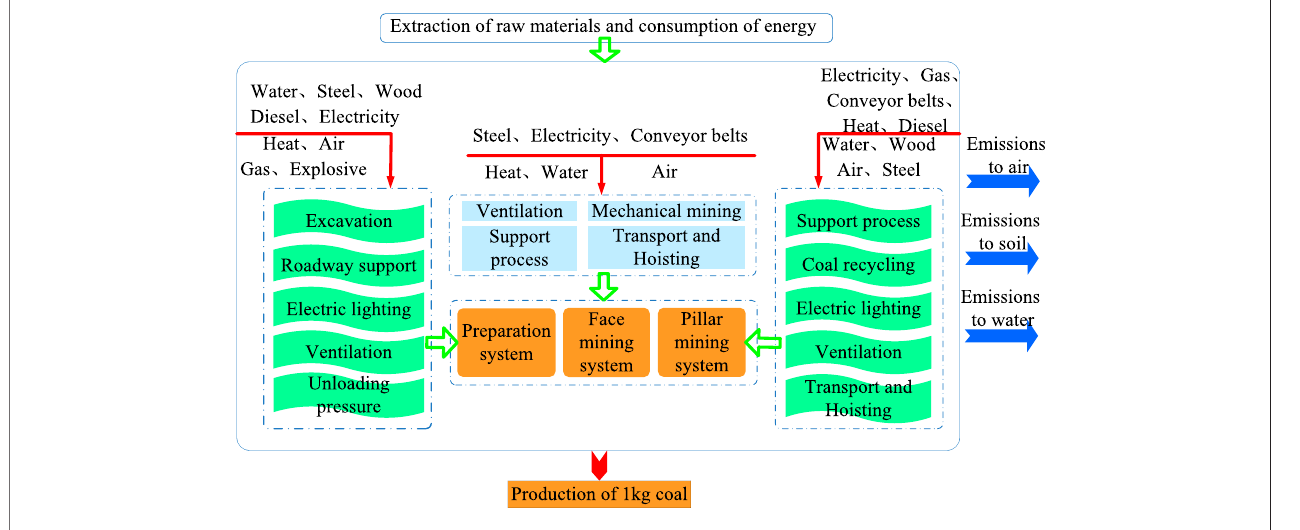
FIGURE 2 | System boundary of the coal production life cycle.